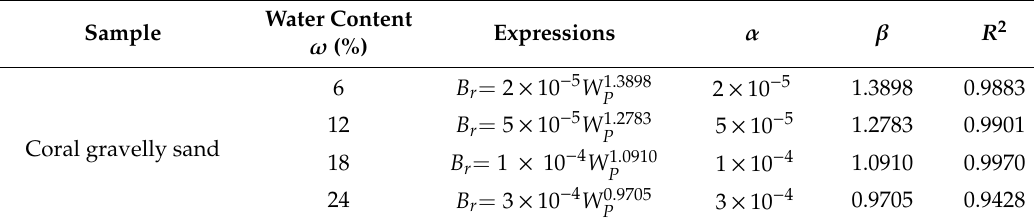
Table 6. Relative breakage index–plastic work fitting formula and parameters.